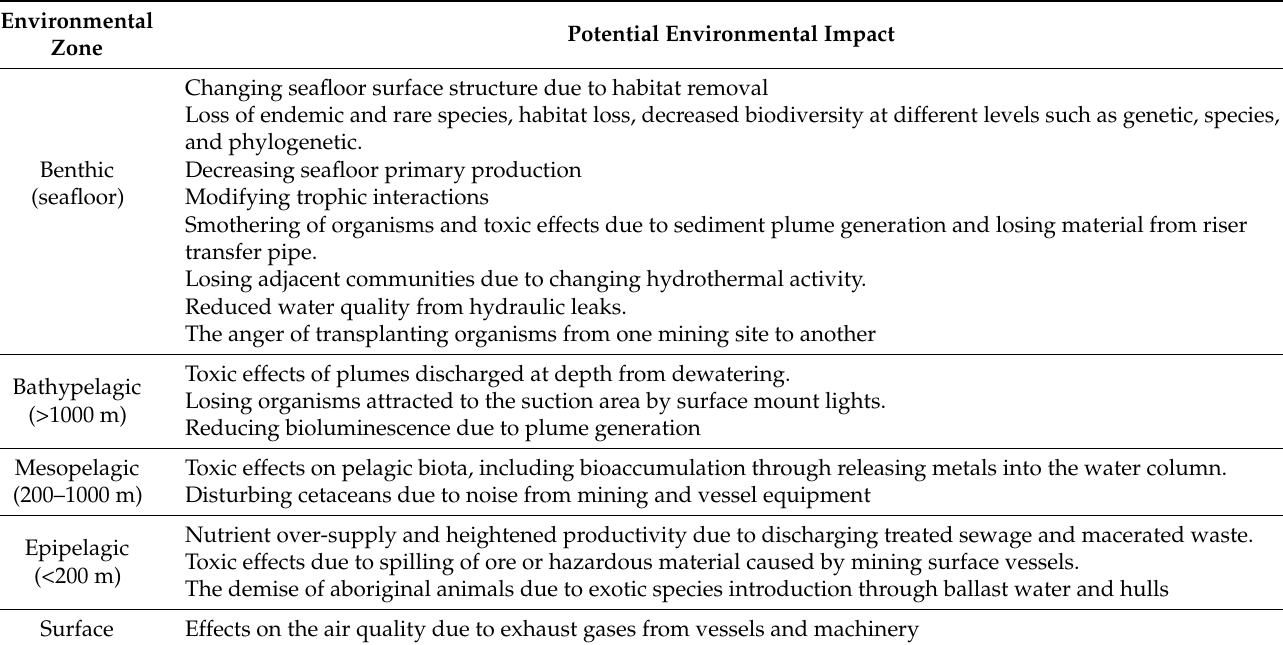
Table 5. Overview of the environmental issues related to the Solwara I project (summarized from [26,36,53–57]).